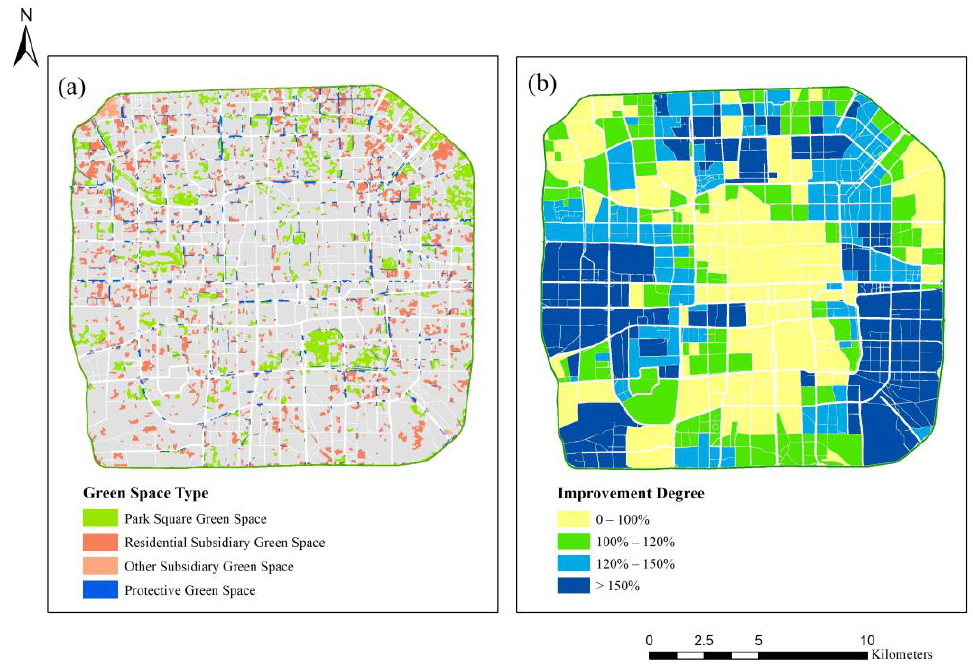
Figure 10. The distribution of six functional UGS (a) and improvement degree after changing in the fourth ring